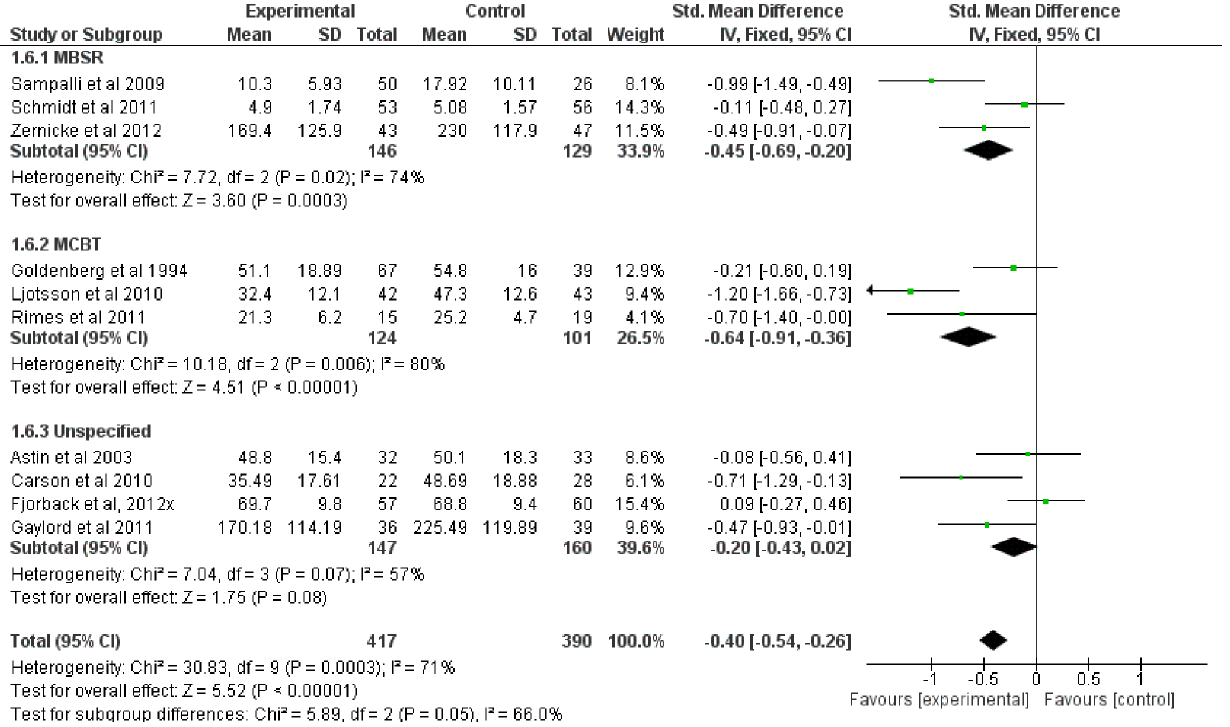
Figure 8. Forest plot showing the effect of type of mindfulness therapy on the symptom severity outcome measure. Standardised mean difference between experimental and control group indicates that the MBSR and MCBT subgroups showed significantly more improvement than the control group, whereas the eclectic/unspecified subgroup did not. doi:10.1371/journal.pone.0071834.g008 PLOS ONE |